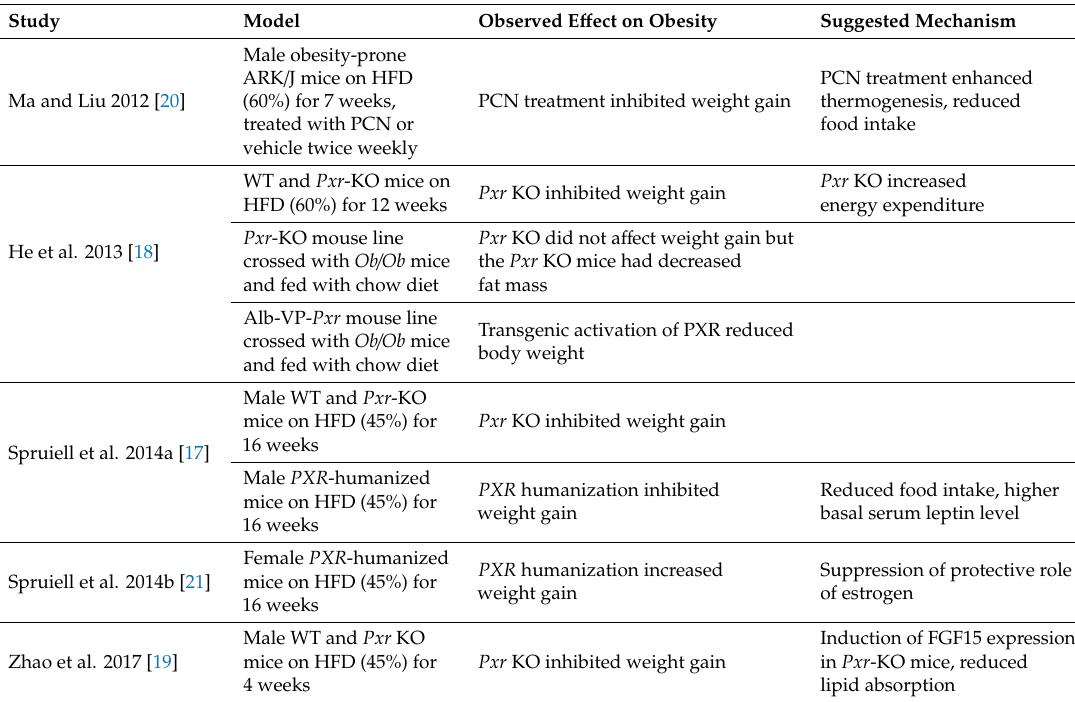
Table 1. Summary of studies on PXR and